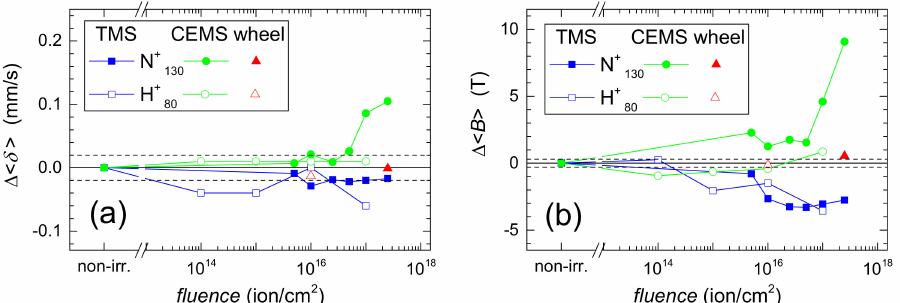
Figure 5. Differences of parameters derived from transmission (TMS, blue) and CEMS (green) Möss- bauer spectra of irradiated and non-irradiated Fe 76 Mo 8 Cu 1 B 15 amorphous metallic alloy exposed to 80 keV H + and 130 keV N + ions as plotted against the ion fluence: ( a ) average isomer shift, ∆ (cid:104) δ (cid:105) ; ( b ) average hyperfine magnetic field, ∆ (cid:104) B (cid:105) . Red triangles correspond to CEMS spectra taken from the wheel side of the ribbons. Solid lines are only guides for the eye, dashed lines represent the error